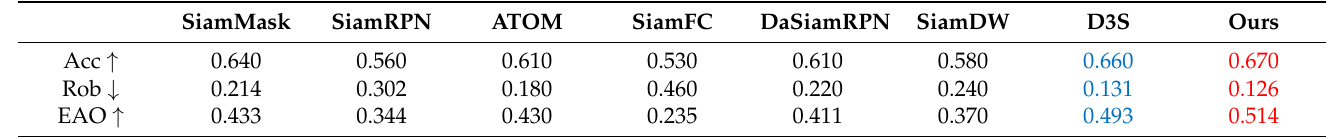
Table 1. Properties comparison on the public VOT2016 dataset with regards to EAO, robustness, and accuracy. Red and blue represent 1st and 2nd, respectively.